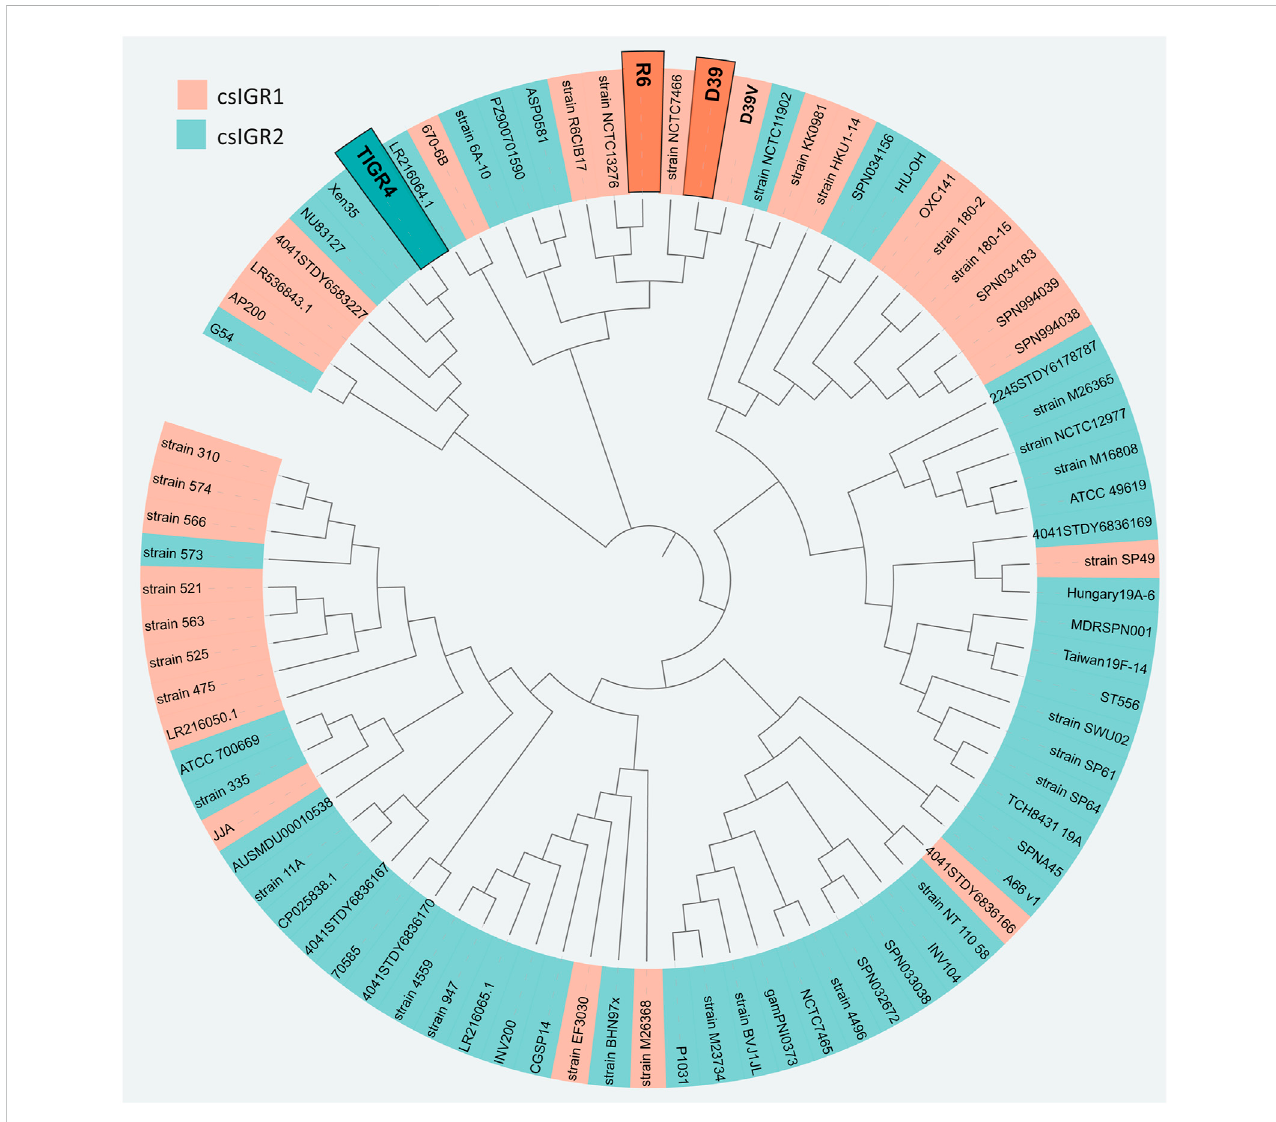
FIGURE 5 Unrooted phylogenetic tree of the 84 S. pneumoniae strains used in this study. The tree is based on SNPs in the core genes. The shading of each label indicatesthepresenceofcsIGR1(orange)orcsIGR2(green).ThetreewascreatedusingRoary,FasttreeandiTol.The S.pneumoniae strainnamesarespeci fi ed if applicable, if no clear strain name was given the sequence ID was